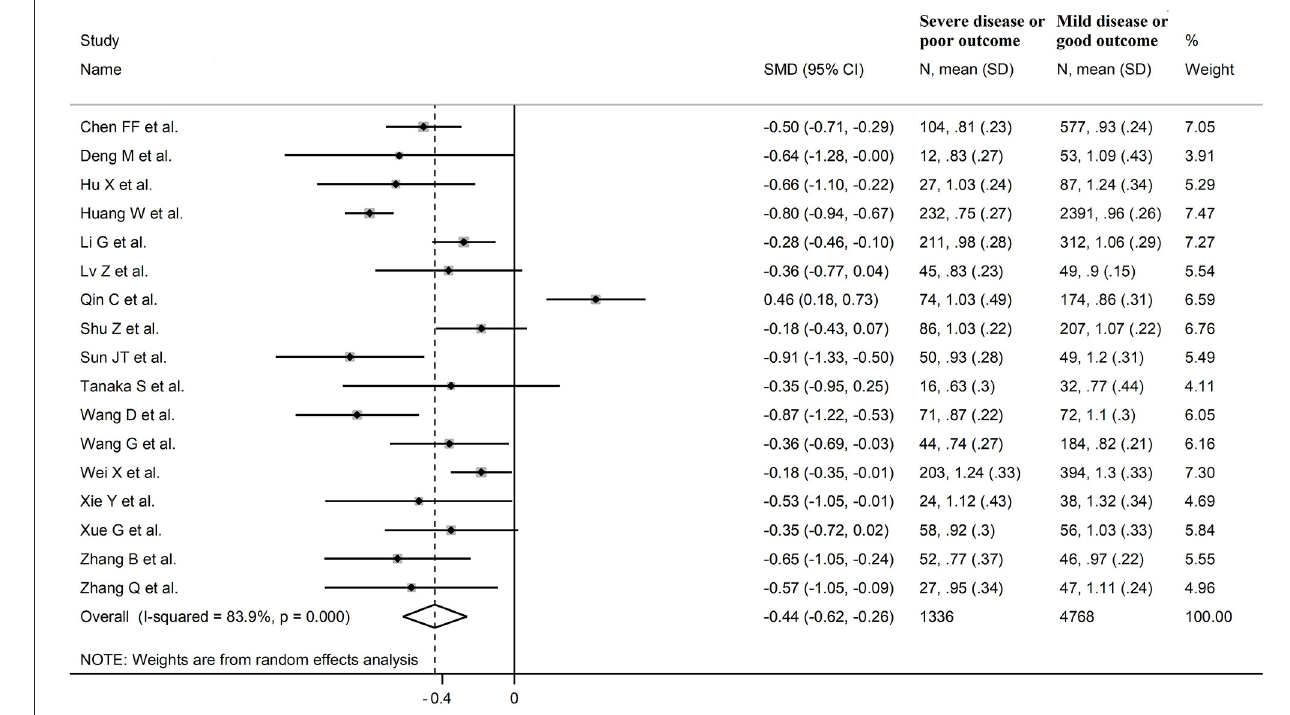
FIGURE 6 | Forest plot of studies examining HDL-cholesterol concentrations in